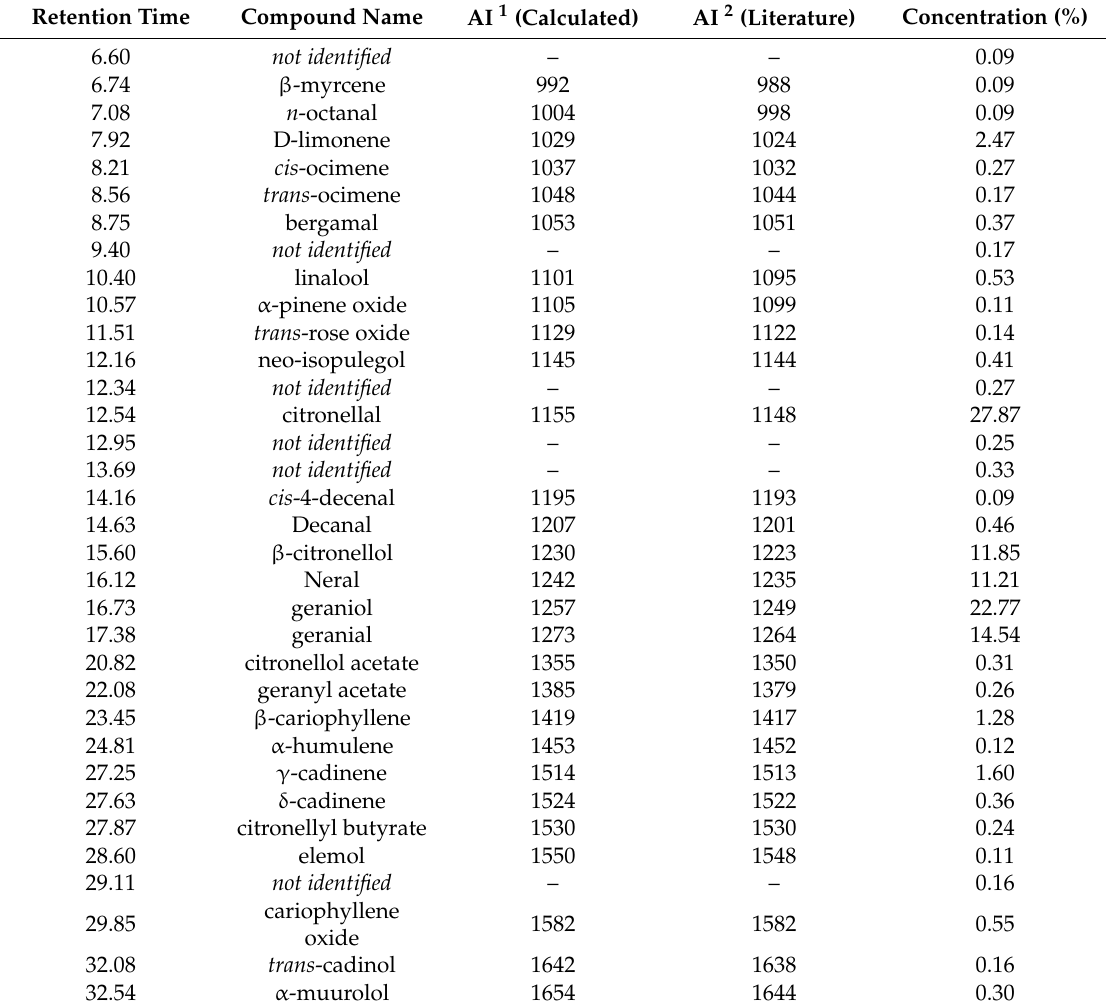
Table 1. Composition of essential oil from the leaves of C. nardus